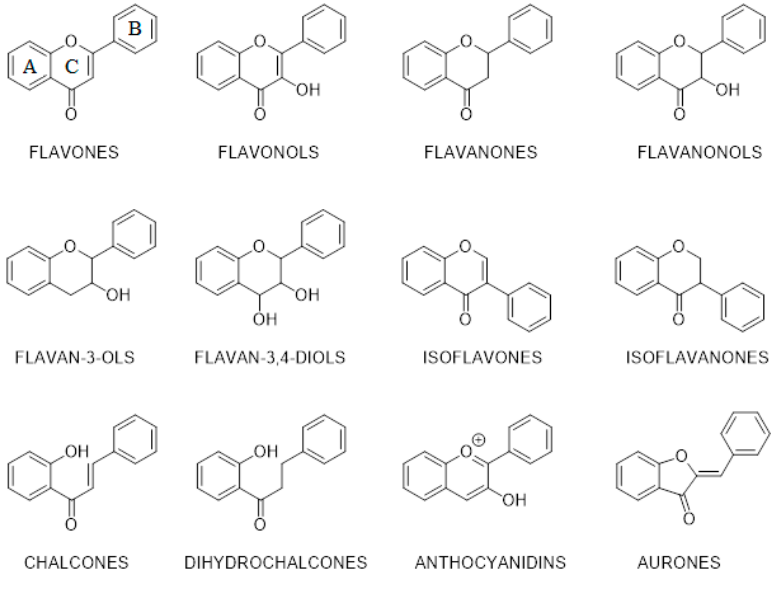
Figure 1. Base structures of classical flavonoid